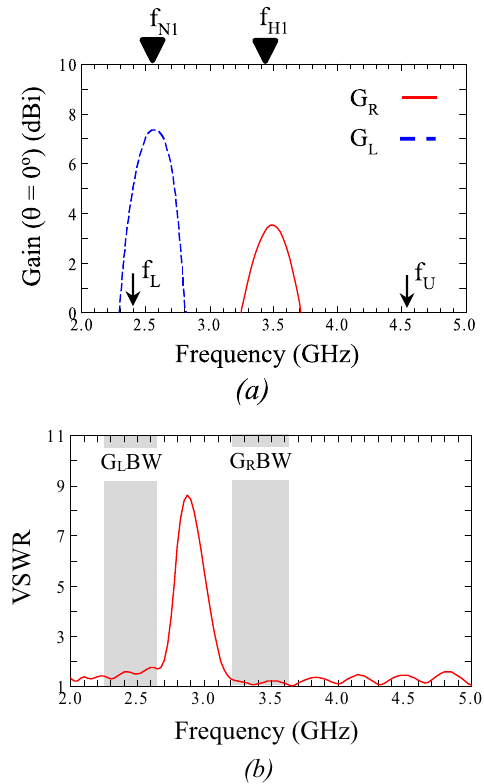
Fig. 15. Frequency response for the round metaloop-N antenna. f N1 =2.55 GHz and f H1 =3.425 GHz. (a) Gain. (b)